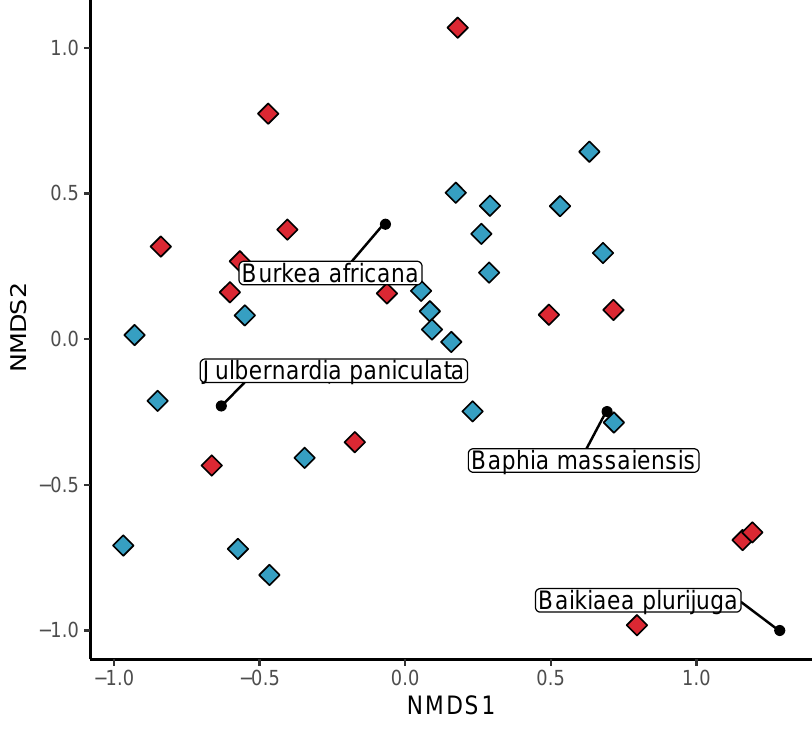
Figure 6. NMDS ordination of species composition of 20 × 50 m (0.1 ha) plots showing plot scores as coloured diamonds located in disturbed (blue) and undisturbed (red) areas of woodland in Bicuar National